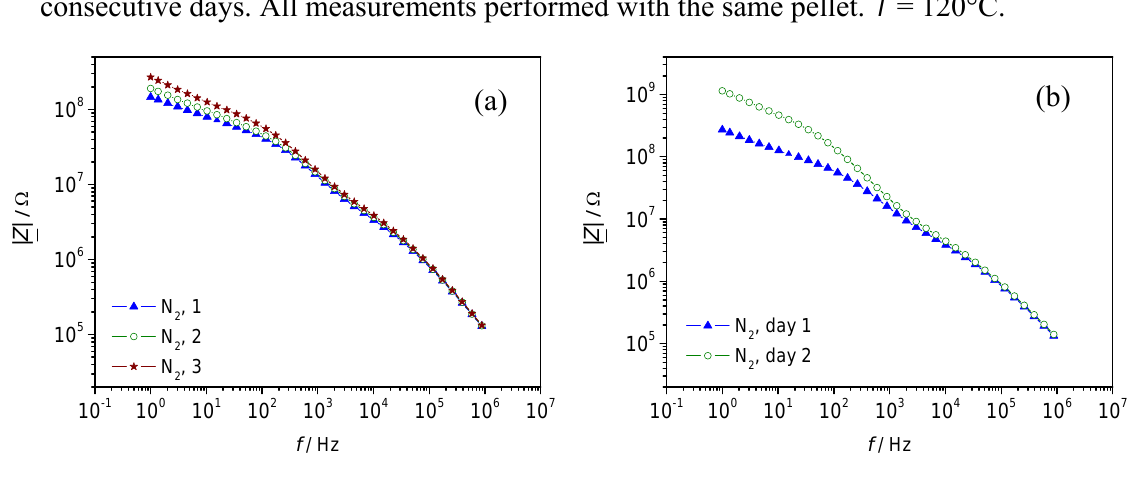
gas atmosphere. 2